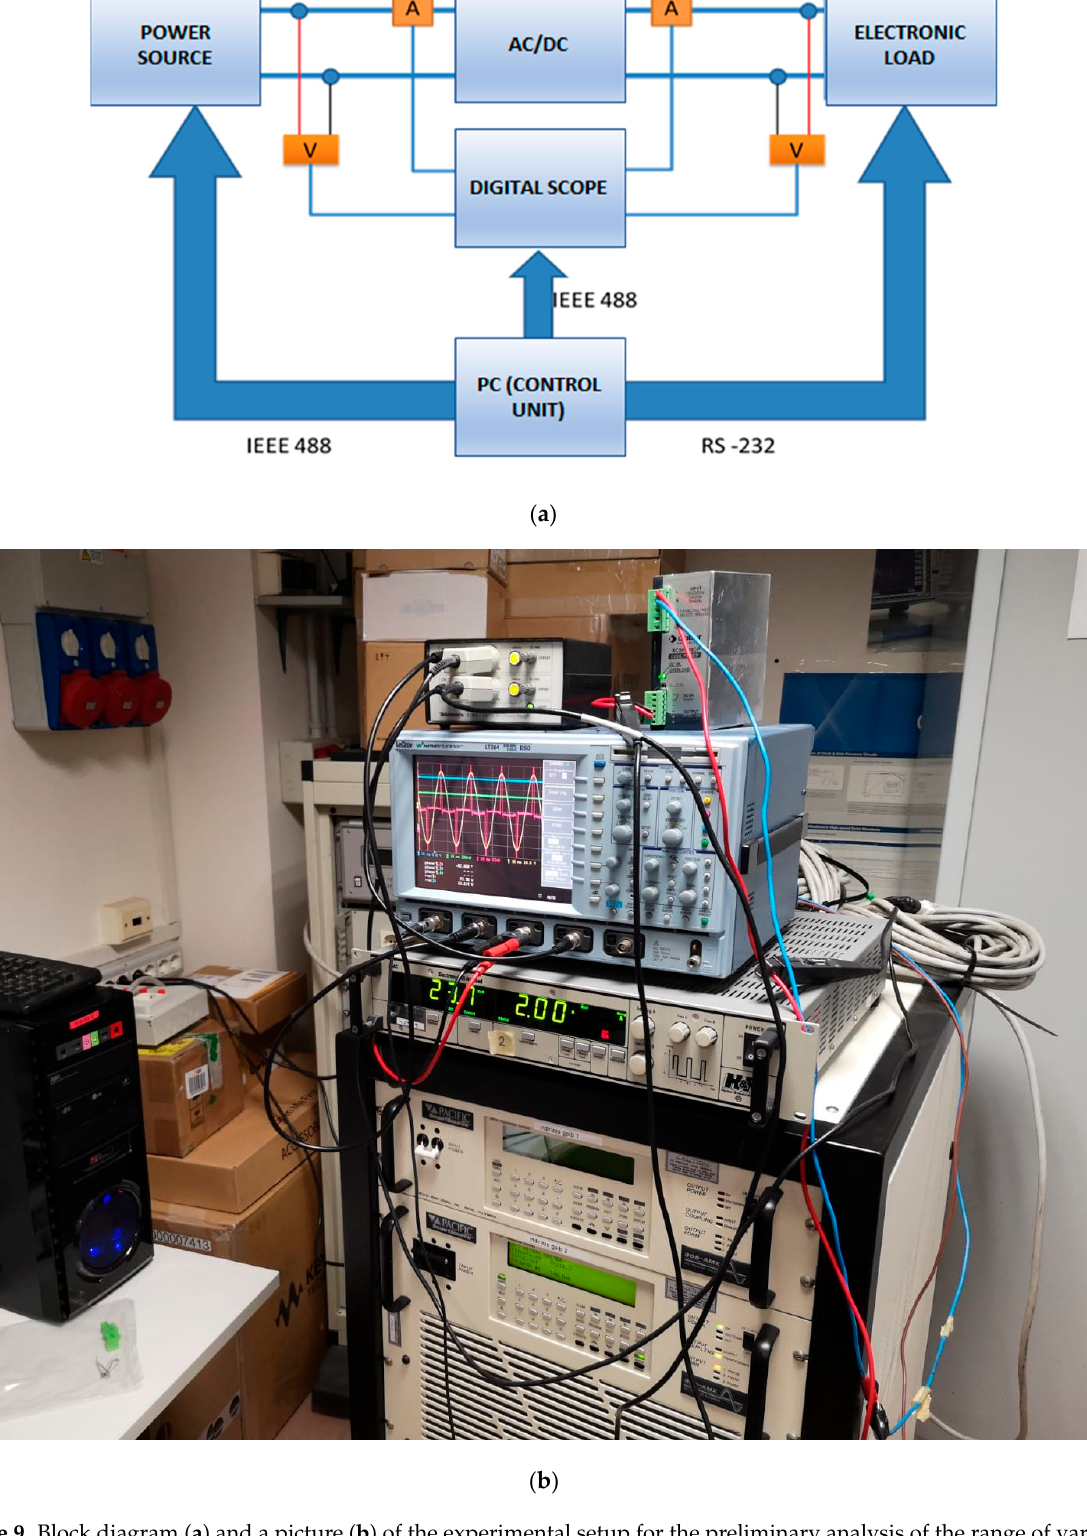
Figure 9. Block diagram ( a ) and a picture ( b ) of the experimental setup for the preliminary analysis of the range of variation of the parameters of interest.